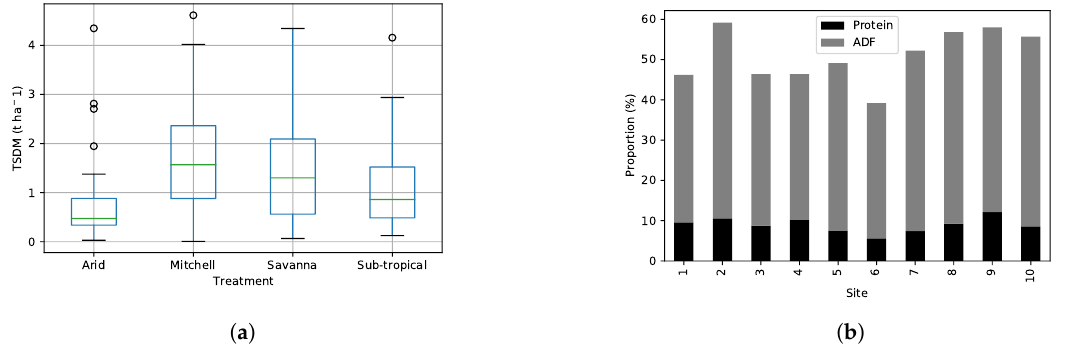
Figure 3. Pasture yield ( a ) and acid detergent fibre and crude protein laboratory results ( b